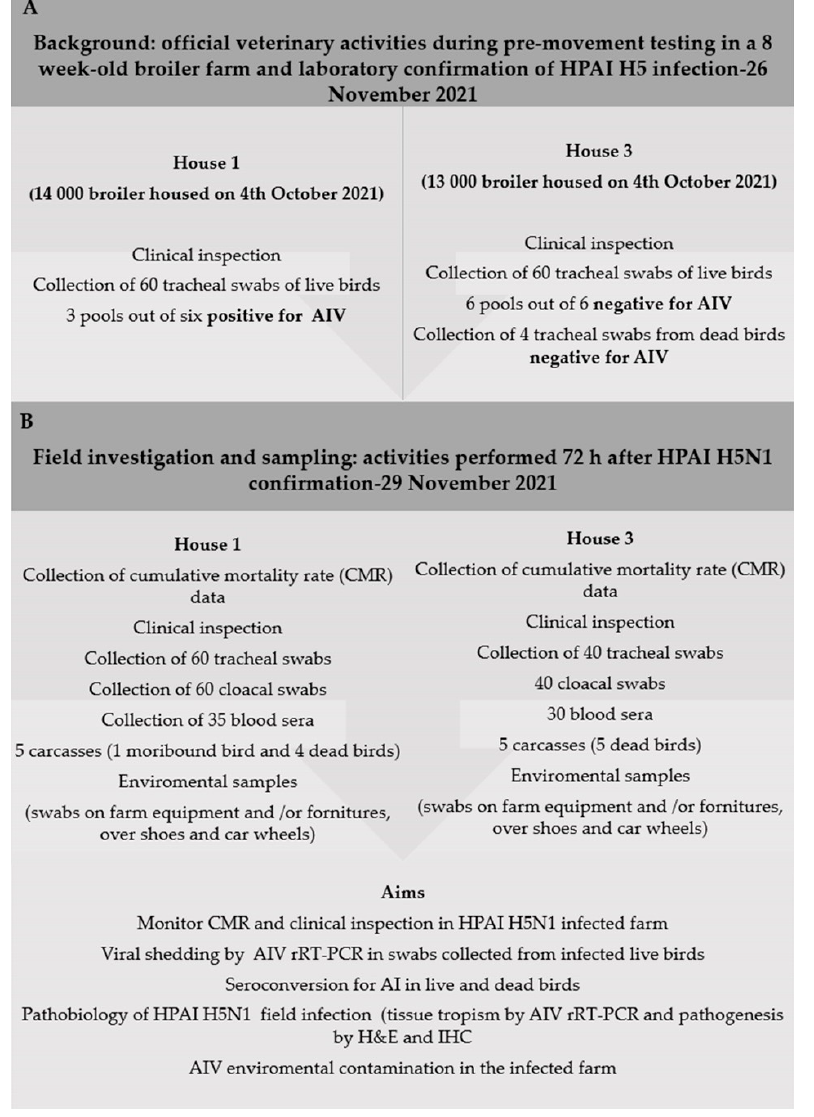
Figure 1. ( A ) Background of H5N1 HPAIV confirmation during the pre-movement monitoring performed by official veterinary authorities in the broiler farm. ( B ) Field activities carried out in the two houses of the affected holding for this study. AIV, Avian Influenza Virus; CMR, cumulative mortality rate; r-RT-PCR, Real-Time RT-PCR; H&E, haematoxylin and eosin staining; IHC, immunohistochemistry.